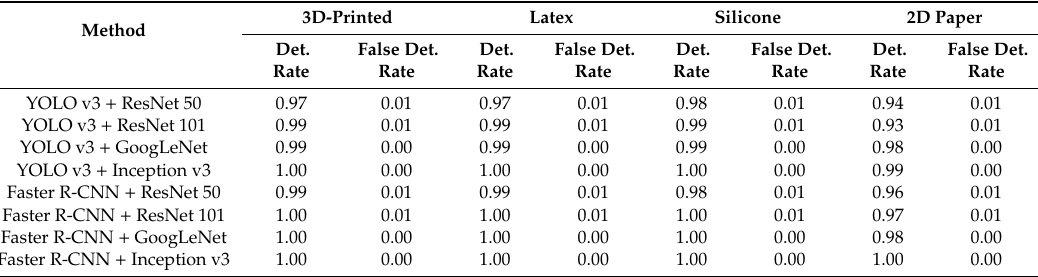
Table 6. Validation results of head detector 1 .